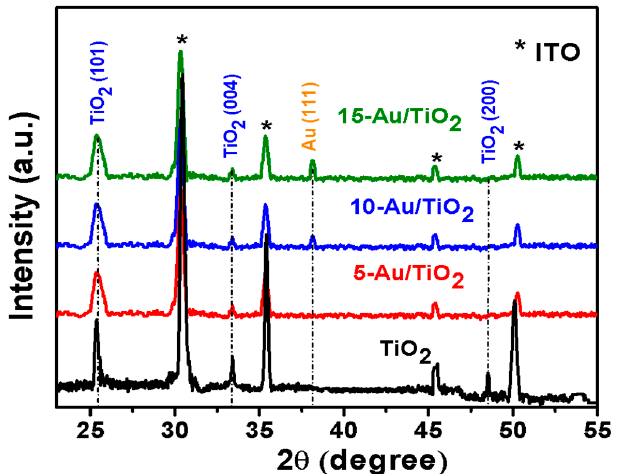
Figure 1. X-ray di ff raction (XRD) patterns using Cu–K α as radiation source of pure titanium dioxide- (TiO 2 ) and gold (Au)-modified titanium dioxide nanofibers (TiO 2 NFs) samples with ultraviolet (UV) illumination times of 5 min (5-Au / TiO 2 ), 10 min (10-Au / TiO 2 ), and 15 min (15-Au / TiO 2 ).